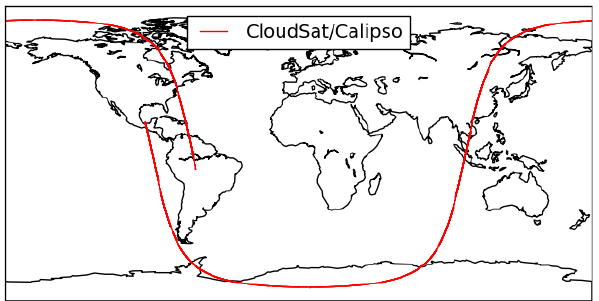
Fig. 2. Trajectory for one selected matched CALIPSO-NOAA- 18 orbit from 6 October 2006 with first matched observation at 18:00UTC (over South America).